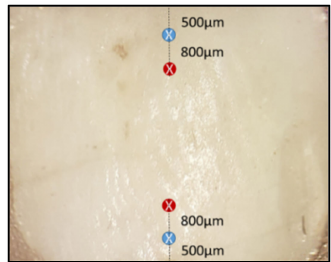
Figure 1. A representative enamel slab illustrates the selected areas that were analyzed by confocal Raman microspectroscopy, followed by Vickers microhardness before pH-cycling (blue circle) and after pH-cycling (red